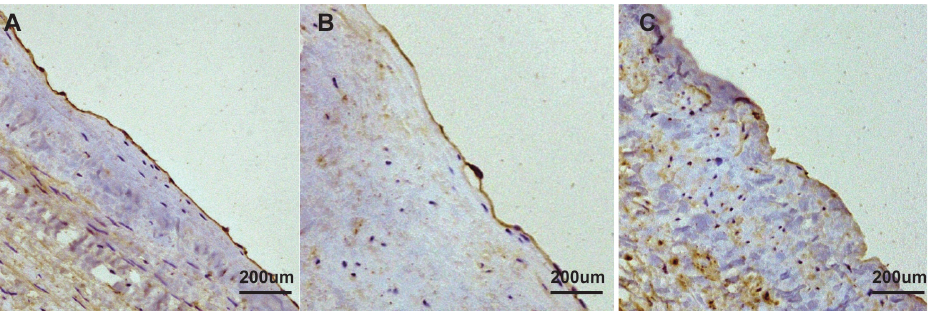
Fig. 4 - Immunohistochemistry staining of human saphenous vein (SV). The endothelial nitric oxide synthases (brown) were stained along with the luminal surface. Adventitial cross-linking preserved the endothelial integrity largely by comparing immunohistochemistry images (magnification, ×200) in different groups. A) Native SV; B) cross-linked and expanded SV; C) non-cross-linked and expanded